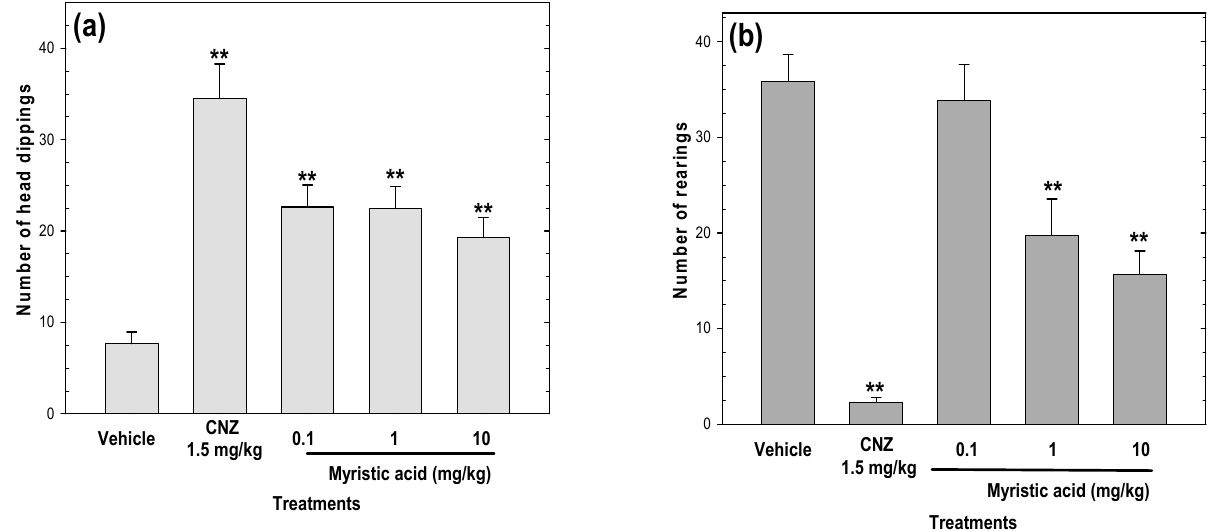
Figure 9. Anxiolytic-like effects of myristic acid (0.1–10 mg/kg p.o.) were measured in the cylinder exploratory test ( a ) and the hole-board test ( b ) during a 5 min exposure. The possible mechanism of action of myristic acid was evaluated in the cylinder exploratory test ( c ) and the hole-board test ( d ). Clonazepam (CNZ) at 1.5 mg/kg p.o. was used as the positive control. Bars represent mean values ( ± SEM) for the experimental group. n = 8, ** p < 0.05 compared to the vehicle group.